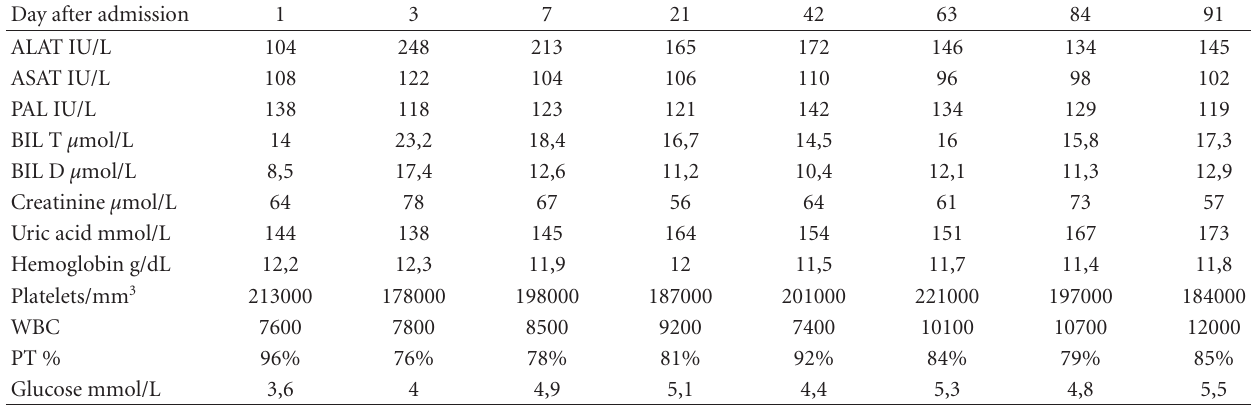
Table 1: Biologic analysis